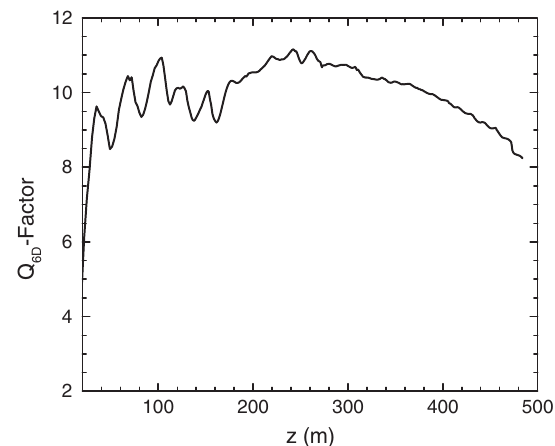
FIG. 8. Evolution of the cooling performance in a tapered cooling lattice. Note that the cooling efficiency Q remains relatively flat through most of the channel, indicating a robust performance, while it drops by only 15% at the last 100 m.